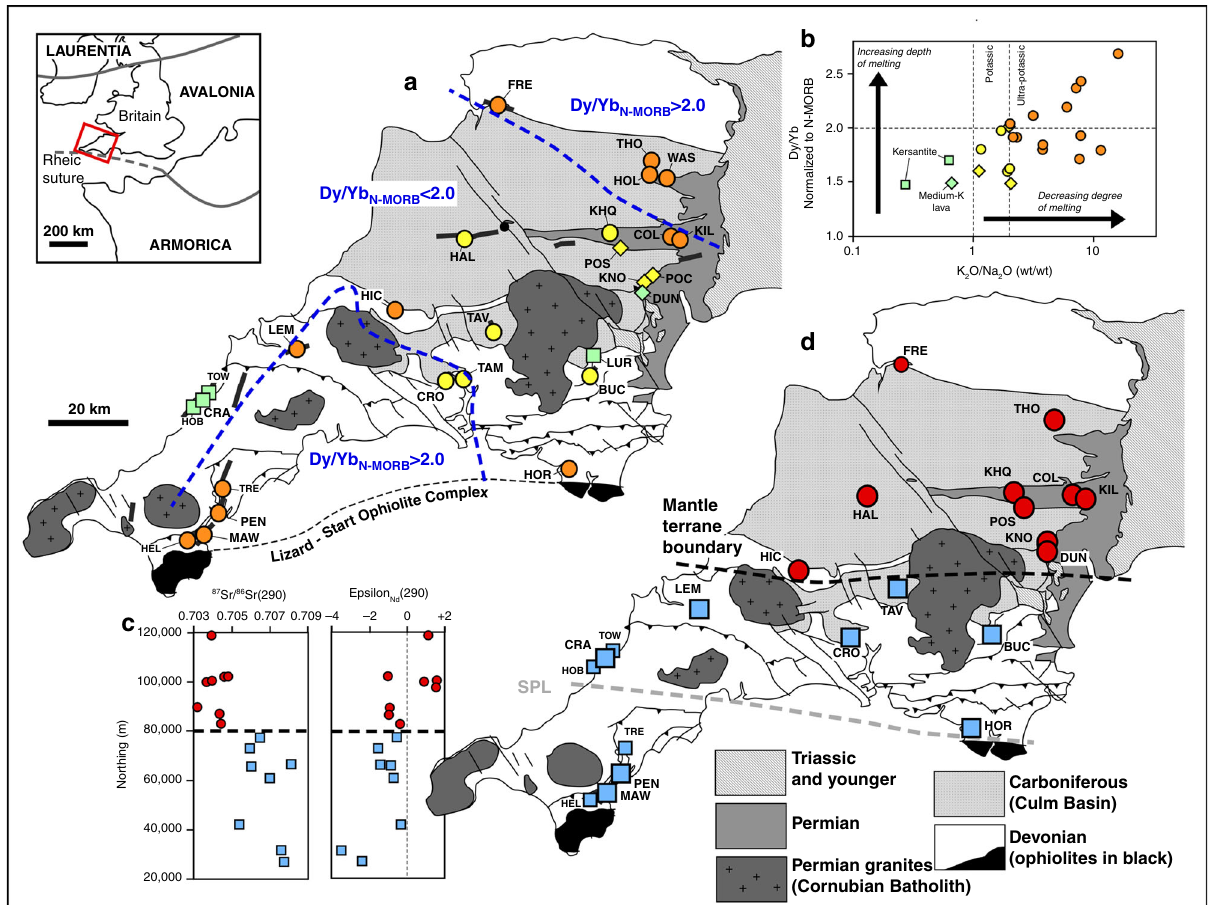
Fig. 1 Geospatial analysis of post-Variscan lamprophyre geochemistry in southwest Britain. Inset map shows location of study area, with the generally assumed location of the Rheic suture marked by the Lizard-Start ophiolites complex. a Map of the study area with sample localities. Samples marked with circles are minette-type lamprophyres, squares are kersantite lamprophyres, and diamonds are mica-free K-rich lavas. Samples are also colour-coded based on K 2 O/Na 2 O ratios. Orange samples are ultrapotassic (K 2 O/Na 2 O >2.2) and represent the lowest degree of mantle melting; yellow symbols are potassic (1 < K 2 O/Na 2 O <2.2) and green symbols represent samples with K 2 O/Na 2 O <1. Two dashed contour lines delineate areas in north and south where deepest-derived magmas were emplaced, based on N-MORB normalized Dy/Yb ratios >2. b Chart showing negative correlation between depth and degree of melting. c Initial Sr and Nd isotope ratios calculated at 290 Ma plotted against northing (Ordnance Survey UK grid coordinates), showing a clear jump in values across thick dashed line. d Map showing the samples assigned to group 1 (red circles) and group 2 (blue squares) based on their initial Sr and Nd isotope ratios. Surface trace of the boundary between the two isotopically distinct lithospheric mantle domains is interpreted as a cryptic terrane boundary in the mantle lithosphere buried beneath Paleozoic metasedimentary rocks. SPL refers to the Start-Perranporth Line (see text). Data for locations TOW (Towan Head), HOB (Holywell Beach), TRE (Trelissick), HEL (Helfort) and FRE (Fremington Quay) are from ref 35 . (only Nd data); all other data from this study. Locations are listed in Supplementary Table 1. Map adapted from regional view geological map from British Geological Survey 59 . © Crown Copyright and Database Right 2018. Ordnance Survey (Digimap